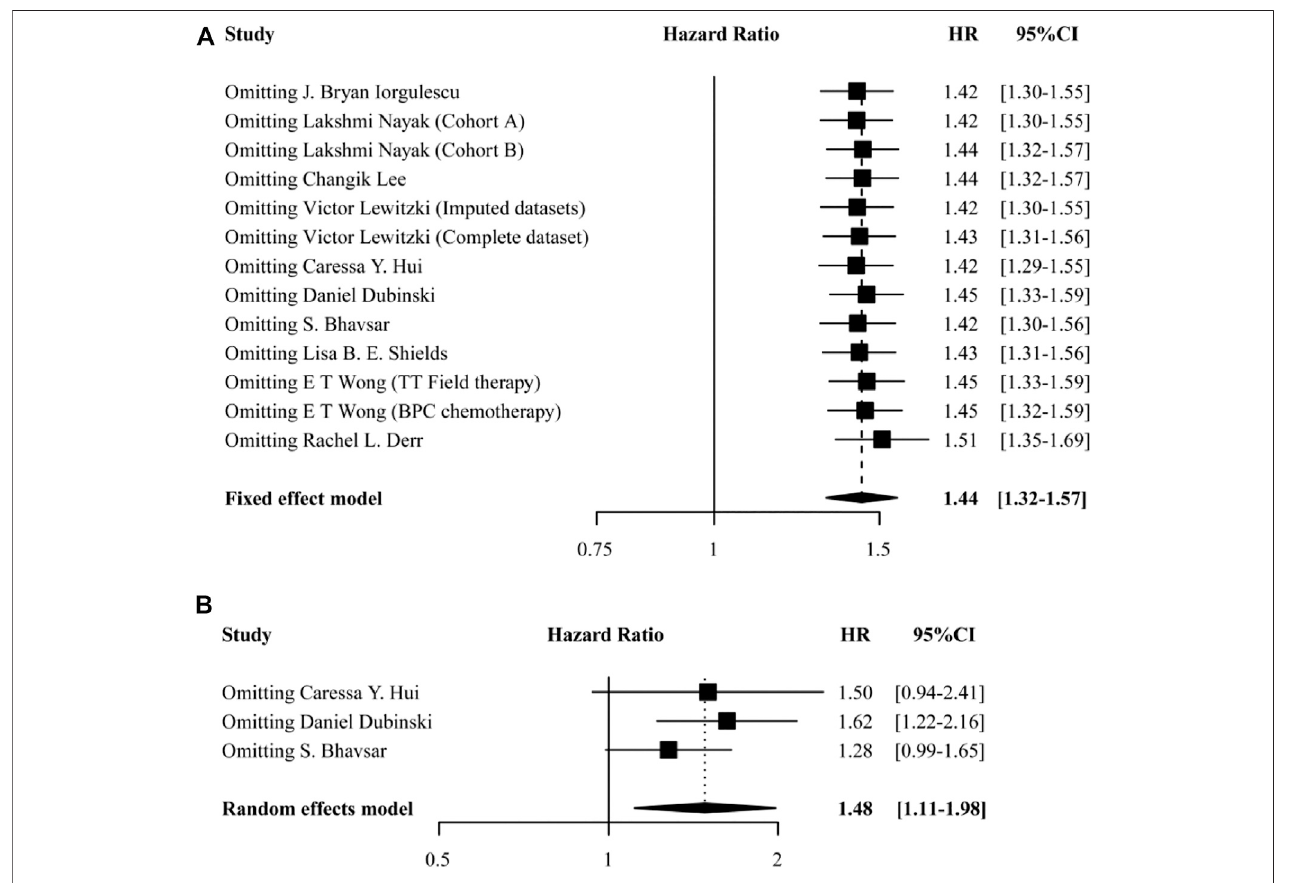
FIGURE 4 | Sensitivity analysis showing the reliability of the pooled result for OS (A) and PFS (B) .